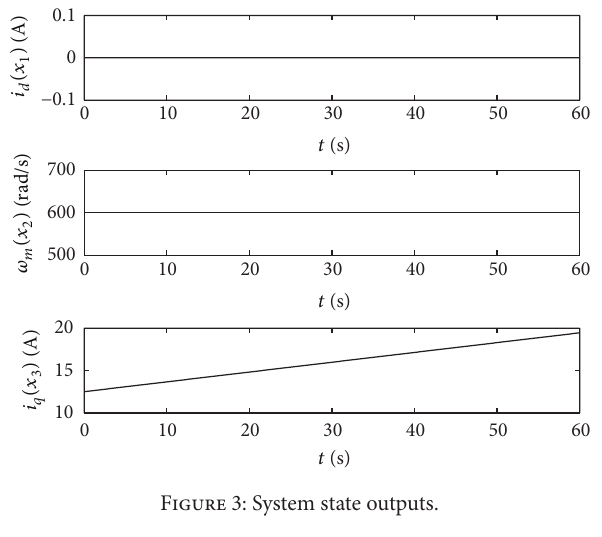
Figure 3: System state